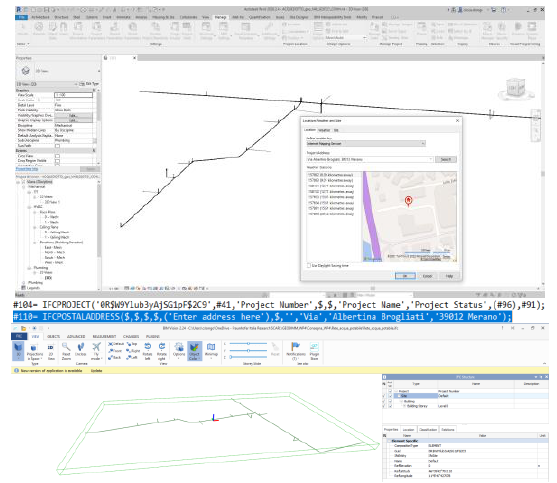
Figure 4b. Toponomy information in IfcSite, from Location in Autodesk Revit, expressed by Longitude, Latitude and